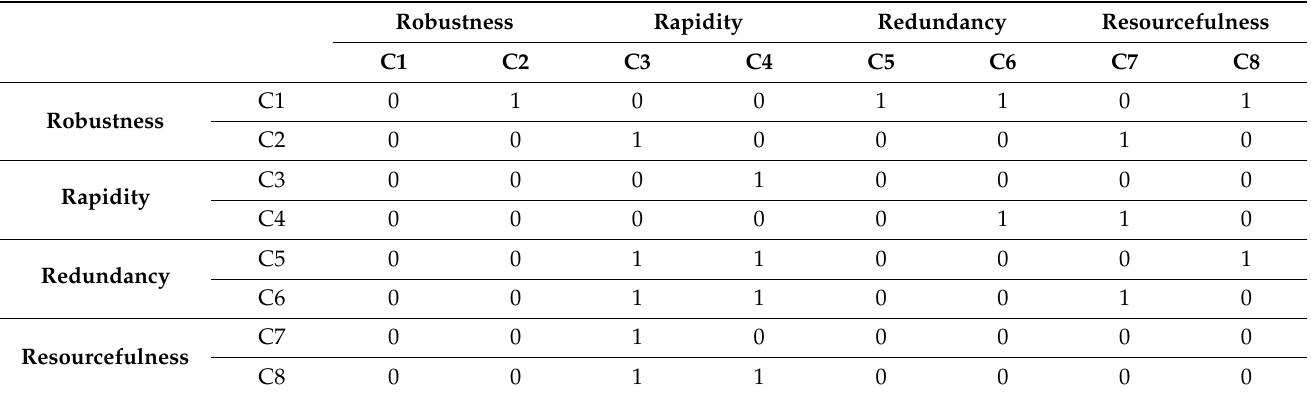
Table 3. Relation matrix of influencing